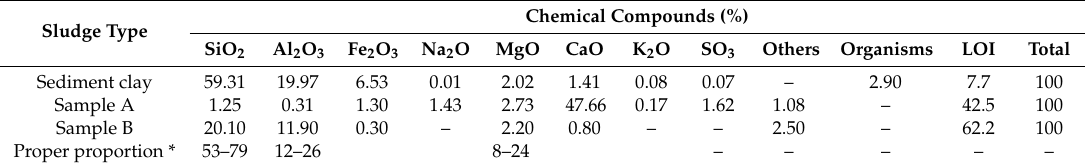
Table 2. Chemical composition of the test